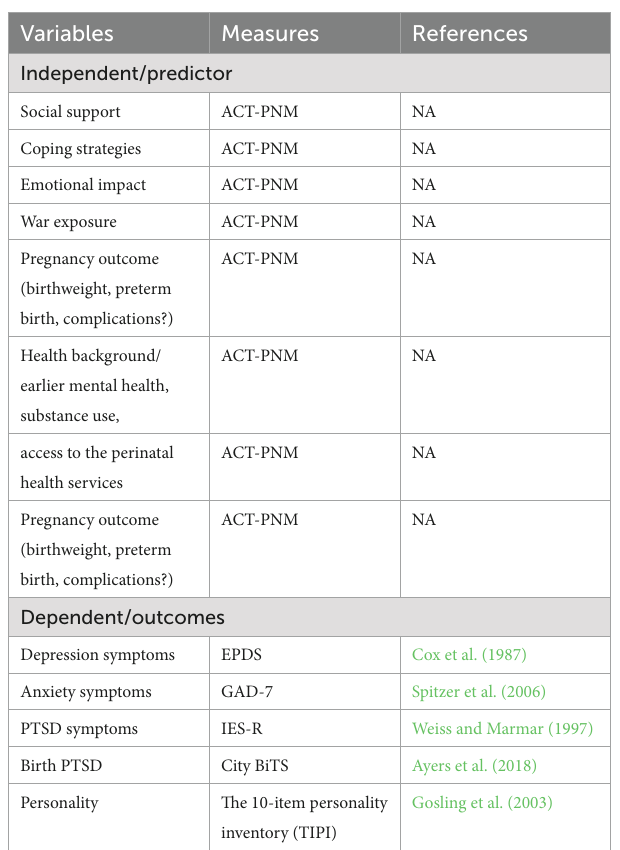
TABLE 1 Variables and measures used in the